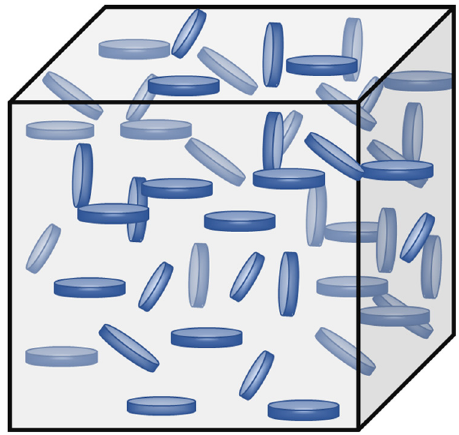
Figure 1: A schematic diagram of a microscale RVE of the ceramic matrix nanocomposite with randomly distributed GNPs or GONPs.